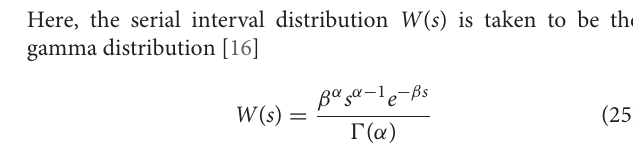
a function of the time 1 relative to the peak time for three values of the Gaussian width w 10, 15, 20. At times below the peak = time 1 < 0, the two doubling times have a similar